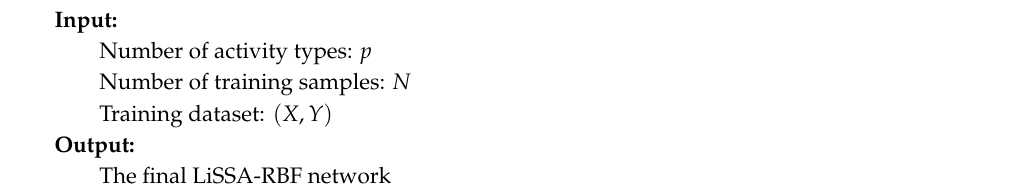
Algorithm 1. Greedy search algorithm for Localized stochastic-sensitive autoencoder-radial basis function (LiSSA-RBF)